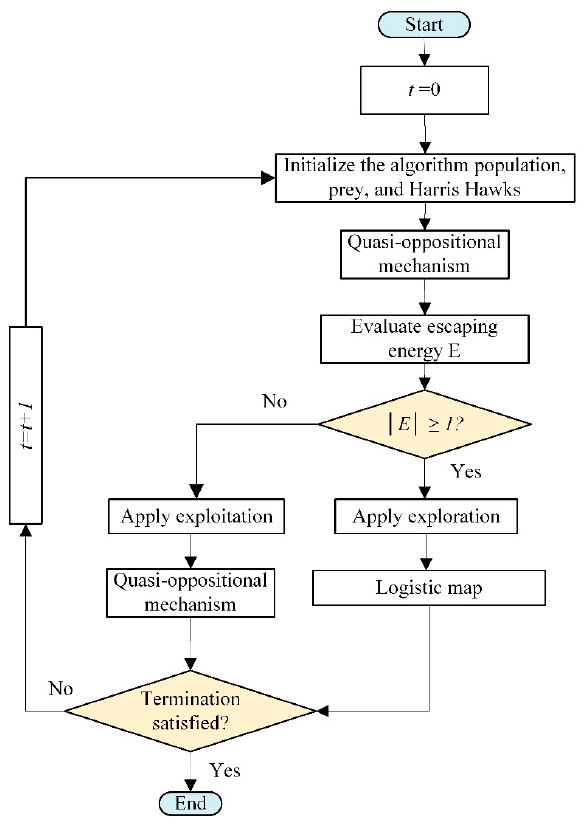
Figure 10. The method of implementing the proposed MOHHO technique.